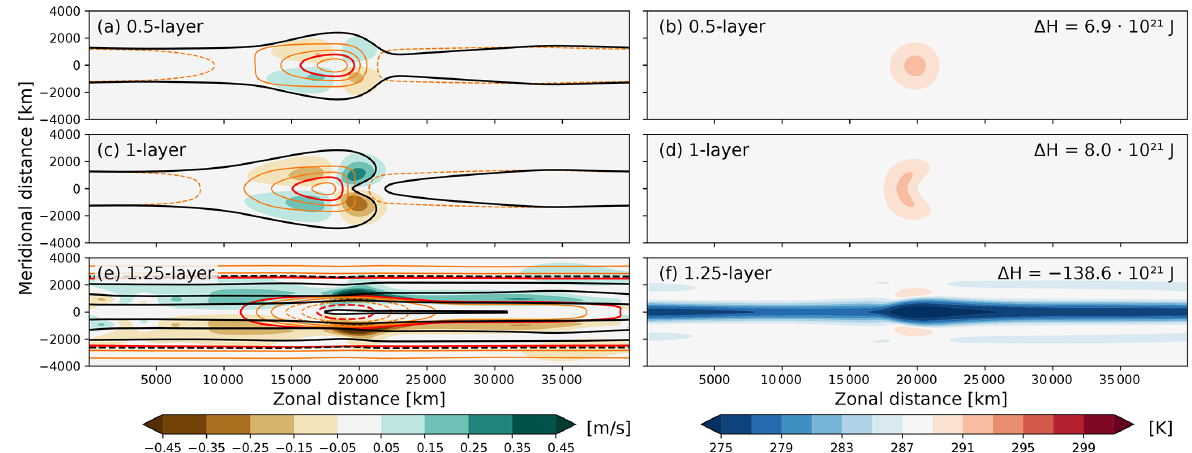
Figure A3. The same as Fig. 12 but for homogeneous-density PE instead of full PE. As in Fig. 12, the maximum zonal wind anomaly on either side of the Equator is about 7ms − 1